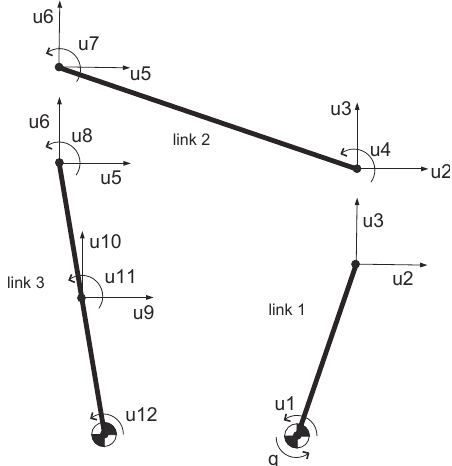
Figure 3. Four-bar linkage: nodal elastic displacement u i and rigid displacement q